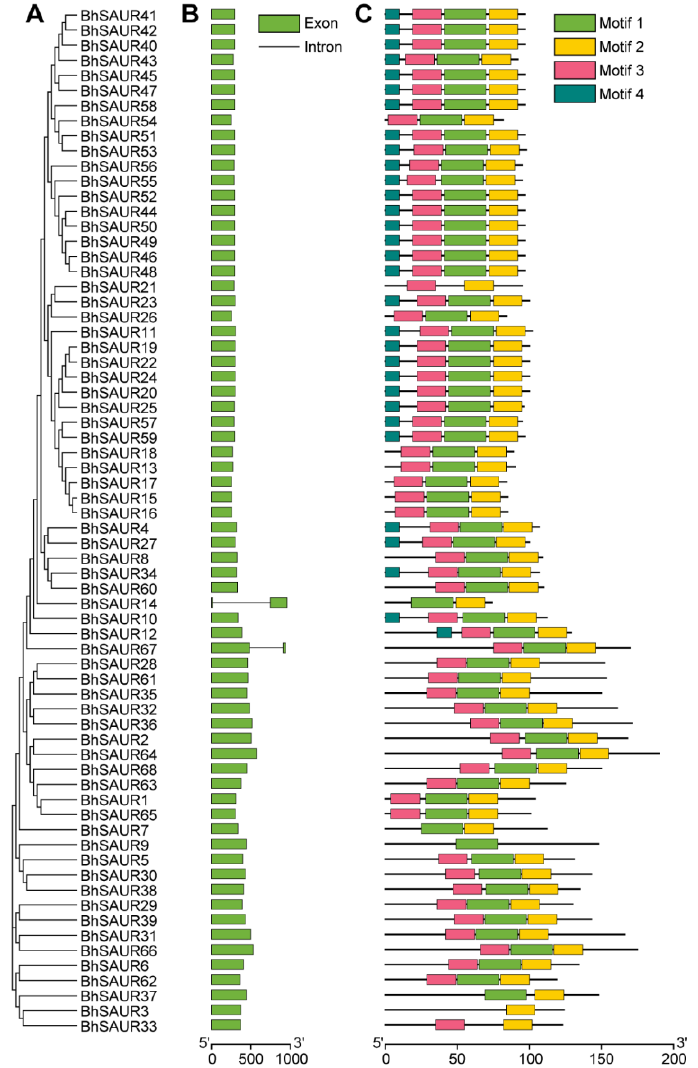
Figure 4. Gene structure and conserved motifs of the BhSAUR genes. ( A ) Phylogenetic tree of the BhSAUR proteins; ( B ) gene structure of the BhSAUR genes; ( C ) conserved motifs of the BhSAUR proteins.